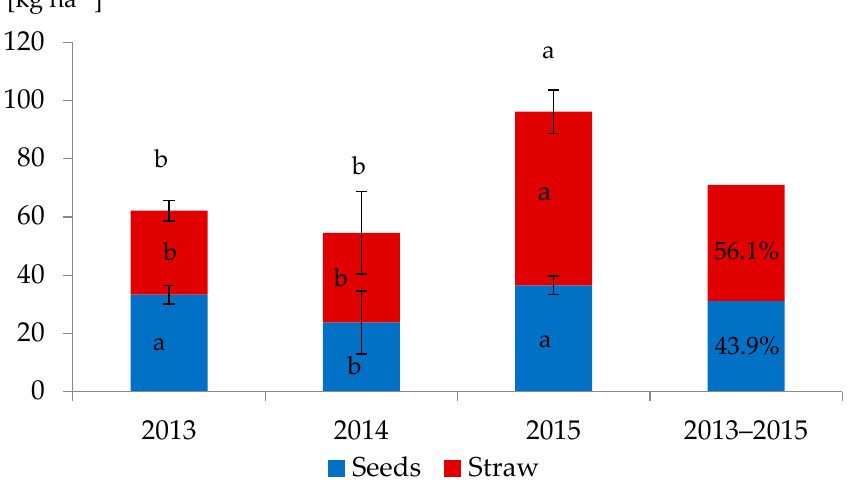
Figure 5. Potassium accumulation (kg ha − 1 ) in whole faba bean plant (average for years). The vertical line atop bar is SD for that mean. Different letters indicate a significant difference (Tukey’s multiple range test).